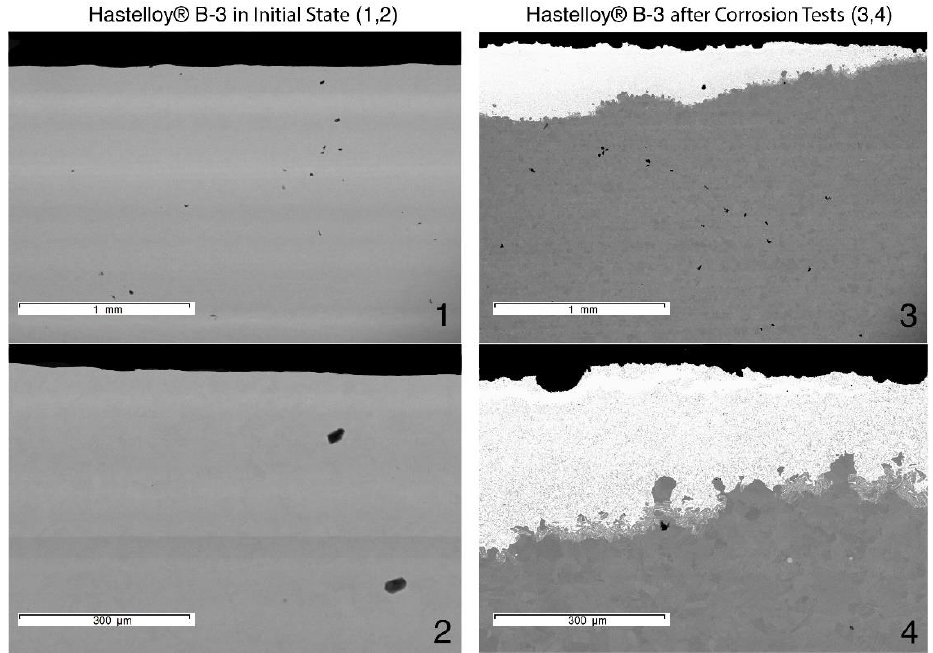
Figure 6. BSE-SEM images of microstructure of Hastelloy ® B-3 Alloy samples before and after contact with BLA at 650 °C for 100 h.